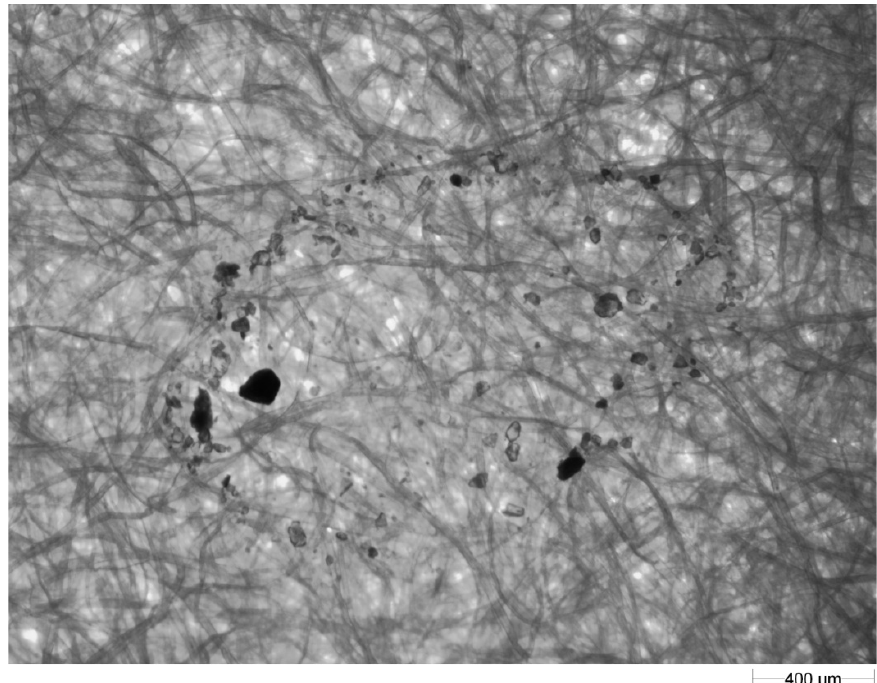
Figure 7. An example image of a drop recorded on blotting paper. The arrangement of all soil particles after drying allows reconstruction of the shape of the splash-inducing drop.